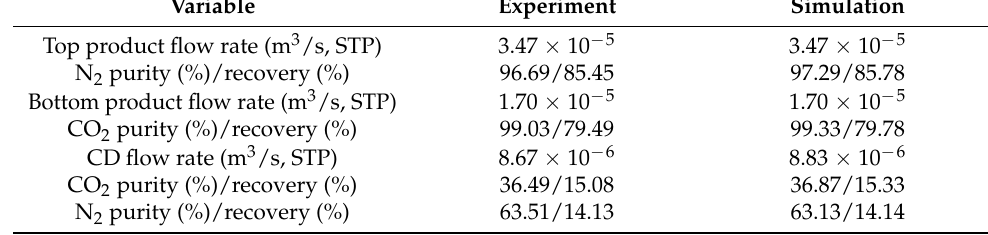
Table 12. Results of the dual-bed six-step PSA process. Variable